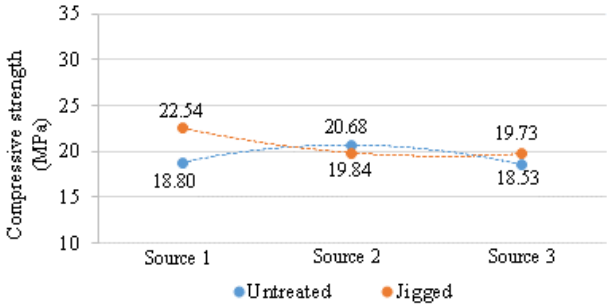
Figure 10. Effect of the source-treatment interaction in axial compressive strength.